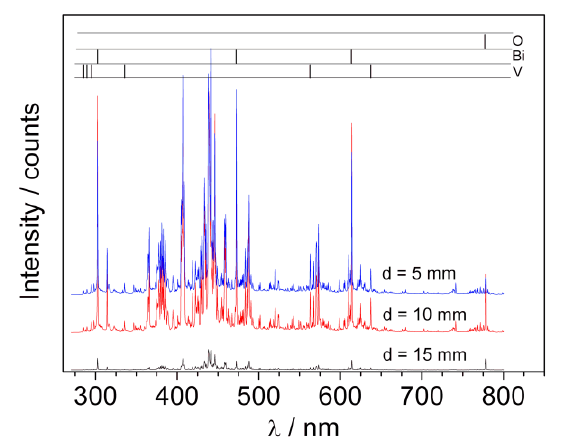
Figure 7. LIB spectra recorded during pulsed laser deposition process at different distances from target and oxygen pressure 2 mbar.